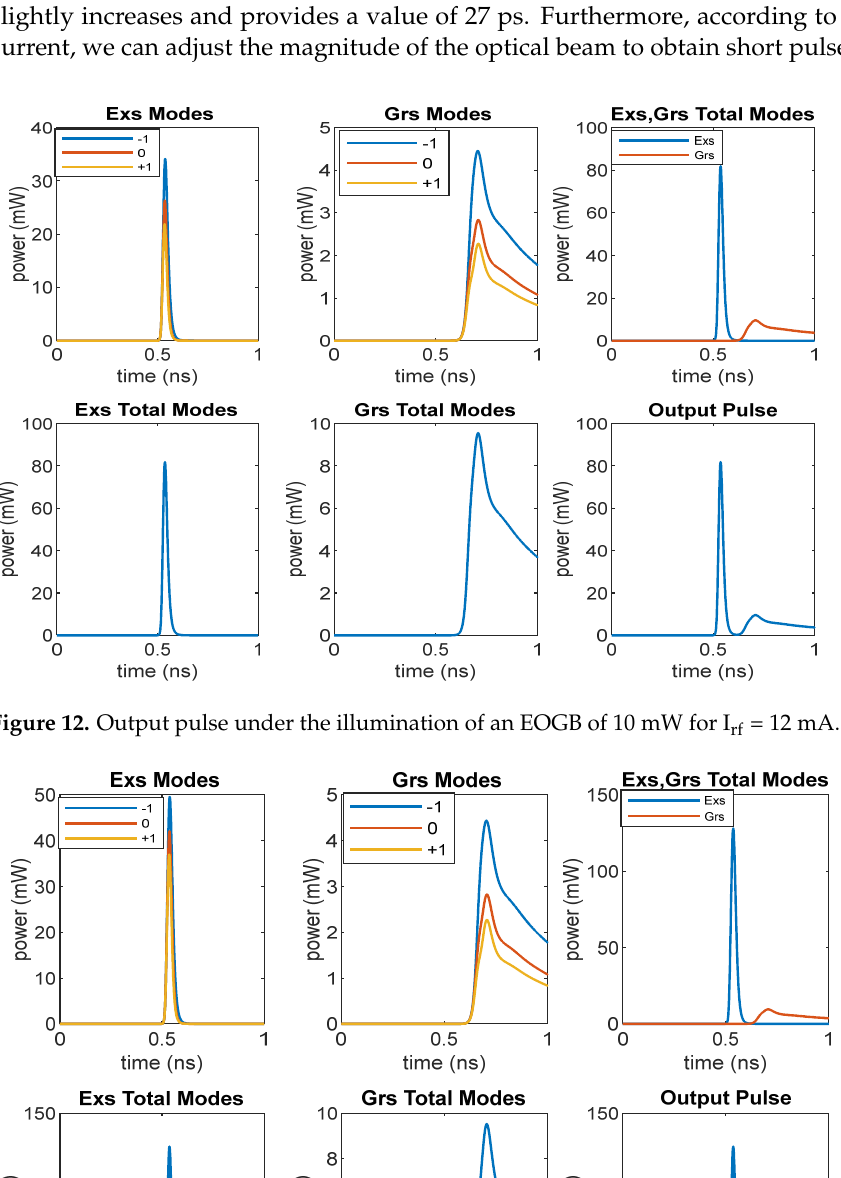
Figure 11. Output power vs. dc current under the EOGB illumination of 10 mW.